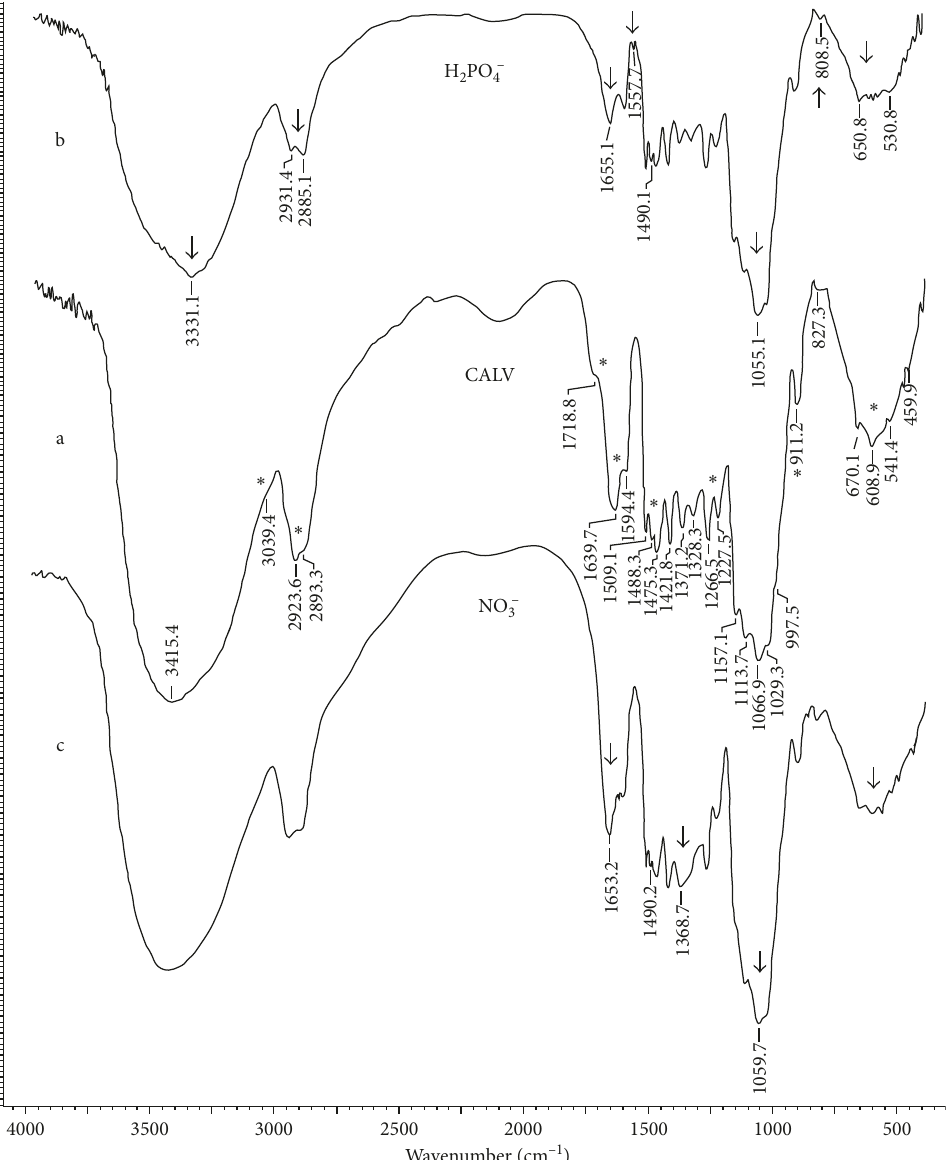
Figure 9: FTIR spectra of CALV biosorbent (a), after phosphate sorption (b), and after sorption of nitrate